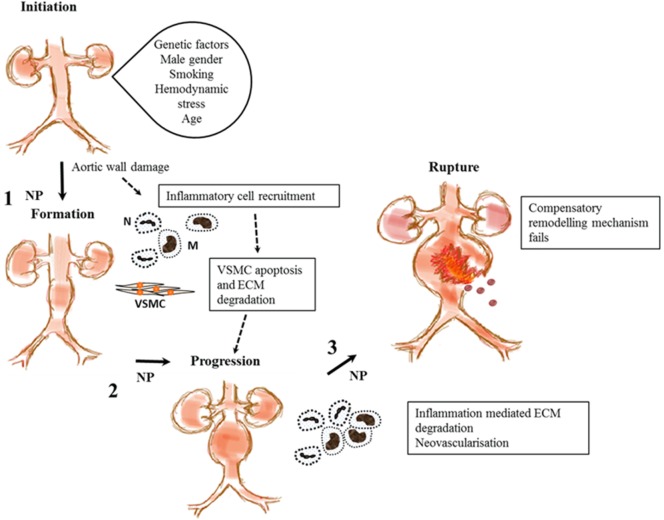
Proposed stages in abdominal aortic aneurysm (AAA) pathogenesis and steps where nanoparticles (NPs) have been used to enhance imaging the disease process. This shows proposed stages in AAA pathogenesis from initiation to rupture. A combination of genetic and environment factors and tissue injury may lead to recruitment of inflammatory cells, macrophages (M), and neutrophils (N) leading to vascular smooth muscle cell (VSMC) apoptosis and extracellular matrix (ECM) degradation. This leads to aortic wall weakening and subsequent aneurysm progression. The aorta tries to repair itself but is overwhelmed by continual inflammation and ECM degradation. Eventually, failure of this compensatory mechanism leads to aortic rupture and death. NPs target inflammatory cells and components of the ECM at steps 1, 2, and 3 to aid in the imaging of functional components implicated in AAA pathology.